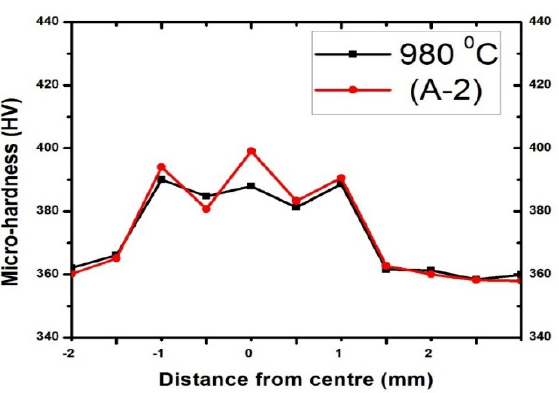
Figure 12. Variation of hardness in different conditions.